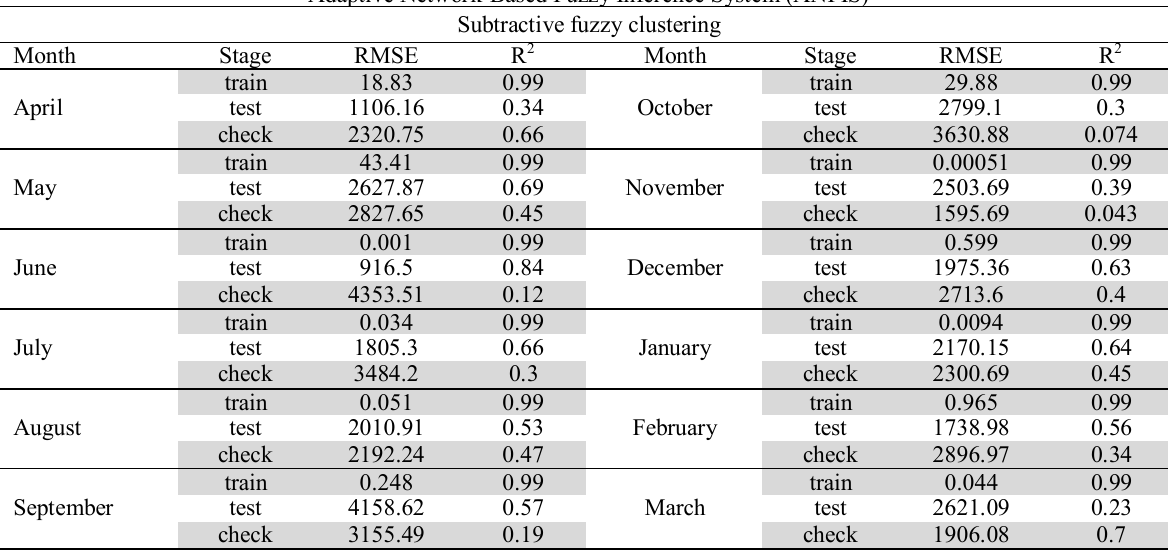
Predicting using fuzzy neural network Adaptive Network-Based Fuzzy Inference System (ANFIS) Subtractive fuzzy